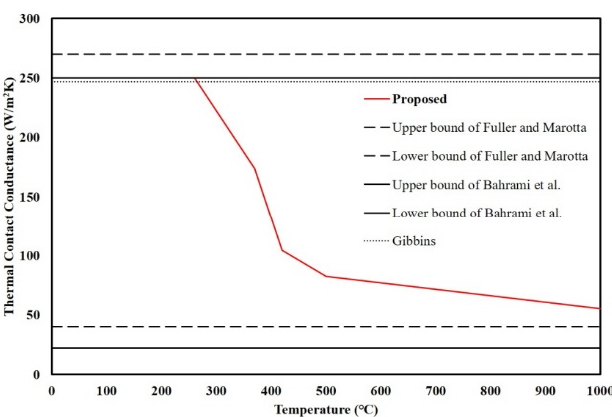
Materials 2020 , 13 , x FOR PEER REVIEW Figure 11. Thermal contact conductance between the steel and polymer at elevated temperatures.